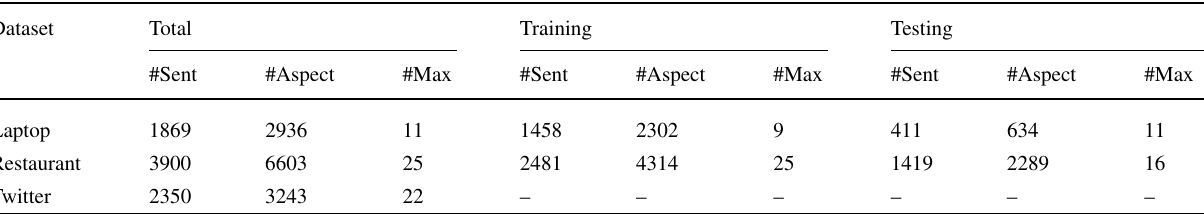
Table 2 The information for all